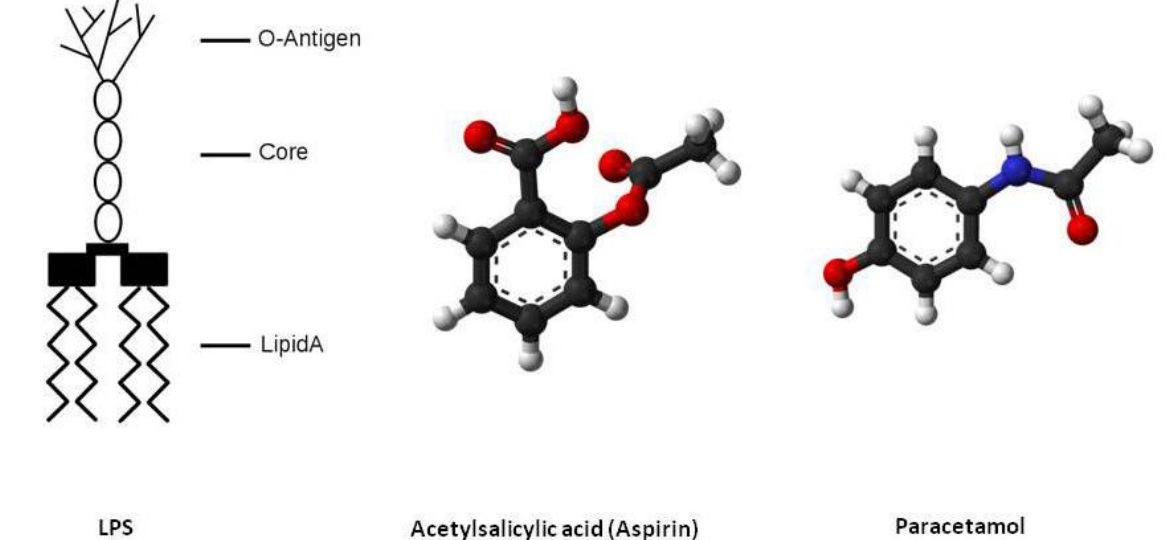
FIGURE 2. Exogenous pyrogens and antipyretic drugs. Molecular models of the exogenous pyrogens LPS and the antipyretic medications acetylsalicylic acid (aspirin) and paracetamol.